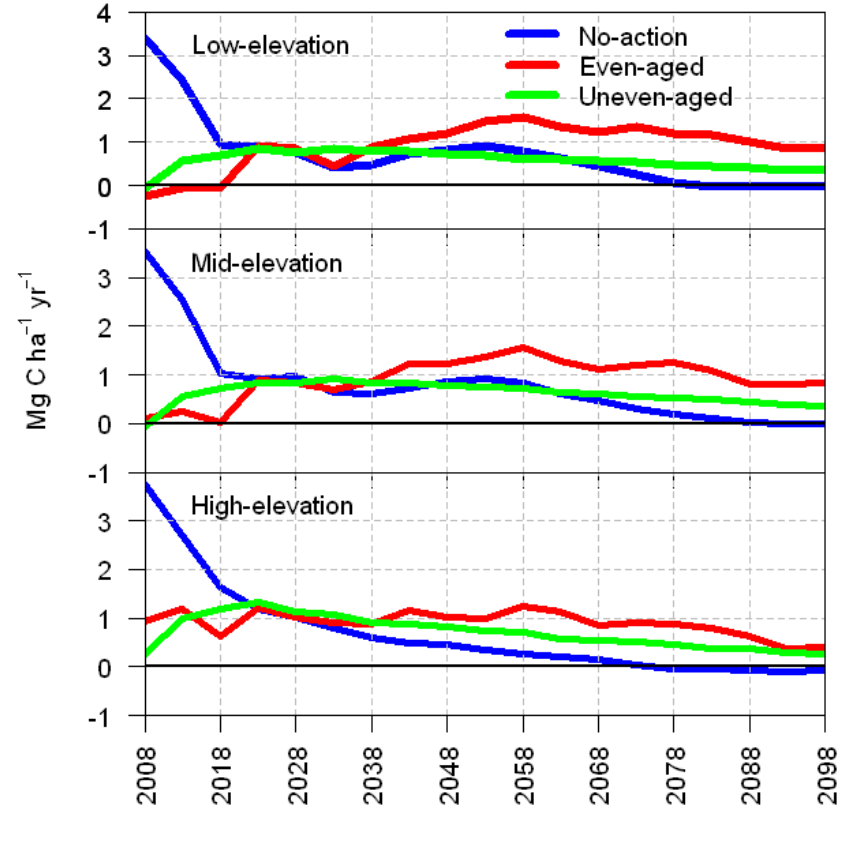
Figure 4. Average annual change in aboveground C (AAC; Mg ha − 1 yr − 1 ) for three elevation groups as a result of no-action, even-aged management and uneven-aged management in a southern Appalachian